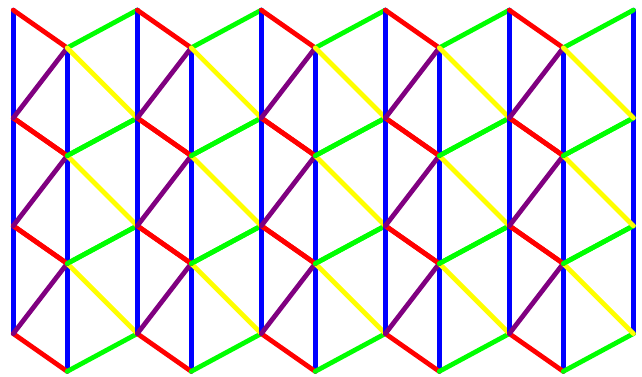
Fig. 15: Tiling with two different non-isosceles non-reflected triangles